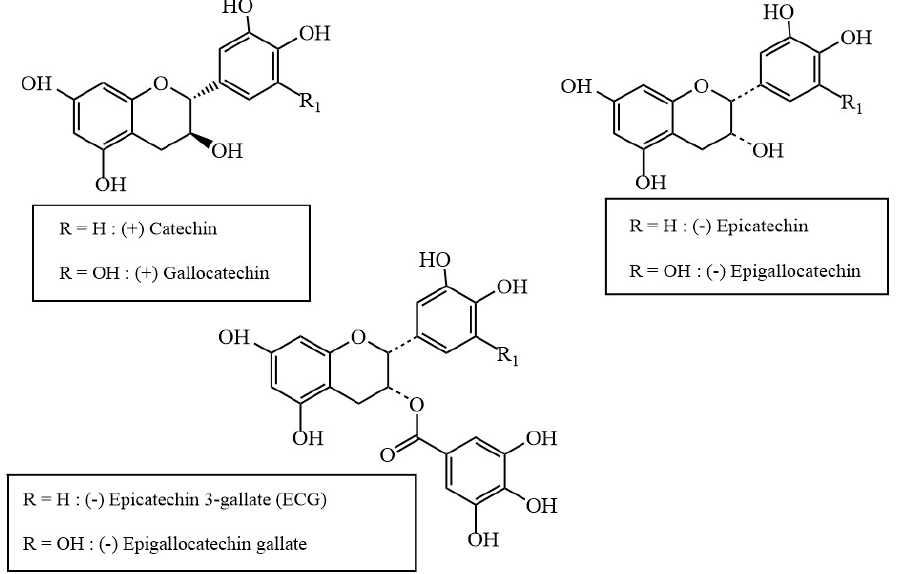
Figure 1. Chemical structures of various catechins found in green tea.